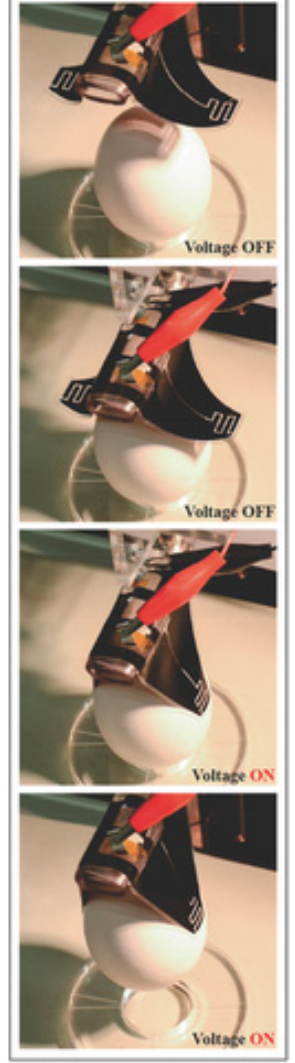
Figure 3. Electro-adhesive Gripper [64] (Copyright 2015, John Wiley & Sons).